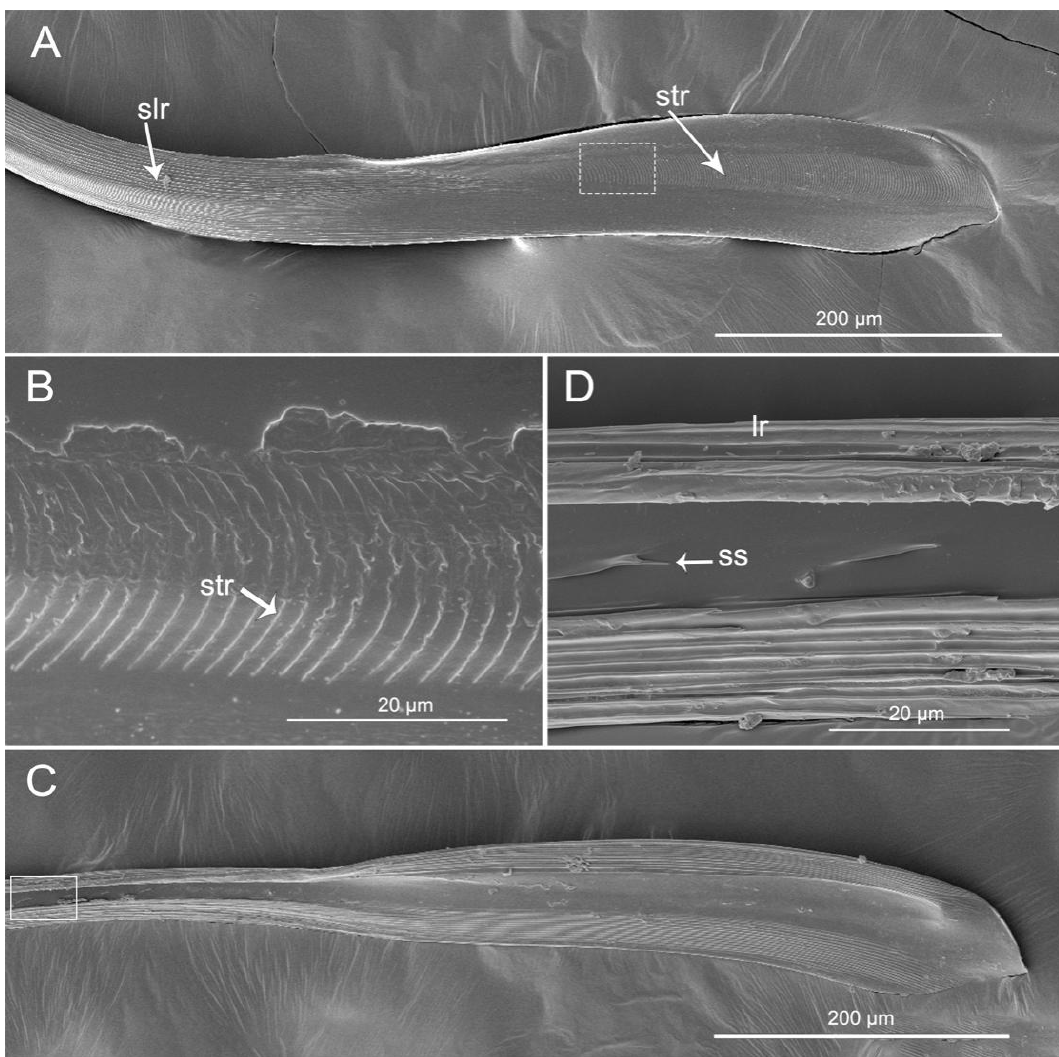
Figure 7. SEM of mandibular stylets of Haematoloecha nigrorufa. A. External view; B. Enlarged view of box in ( A ); C . Interior view; D . Enlarged view of box in ( C ); slr, strong longitudinal ridges; str, slightly transverse ridges; lr, longitudinal ridges; ss, small spinule.